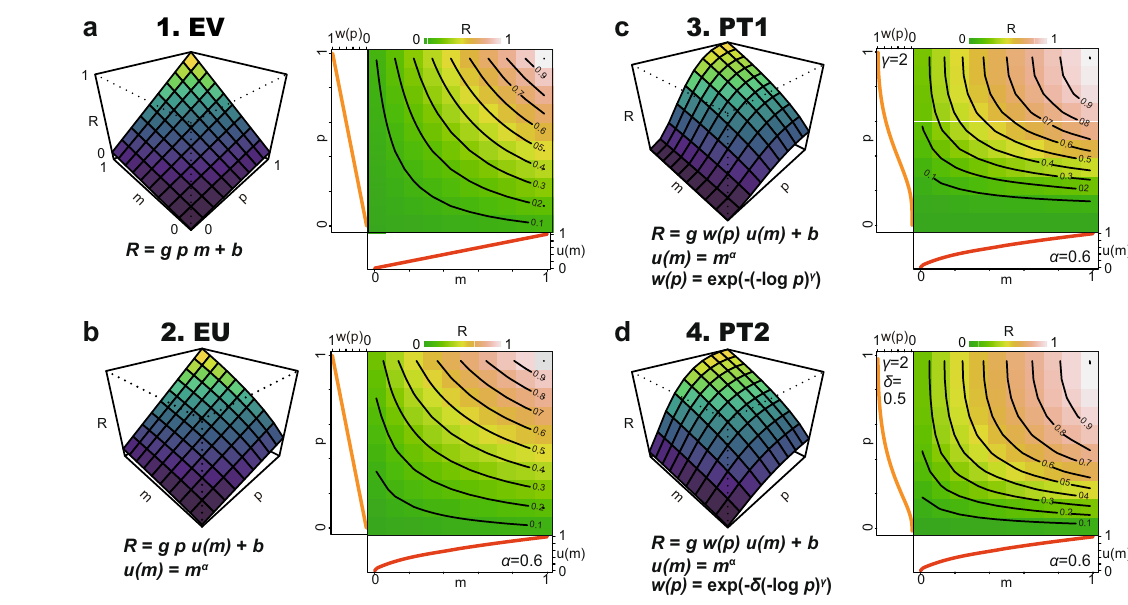
intercept parameters, respectively. α represents the curvature of u(m) . δ and γ represent the probability weighting functions. For these schematic drawings, the followingvaluesforthefreeparameterswereused: b , g , α , γ ,and δ were0spks − 1 ,1, 0.6, 2, and 0.5, respectively, for all four Figs. See the Methods section for more